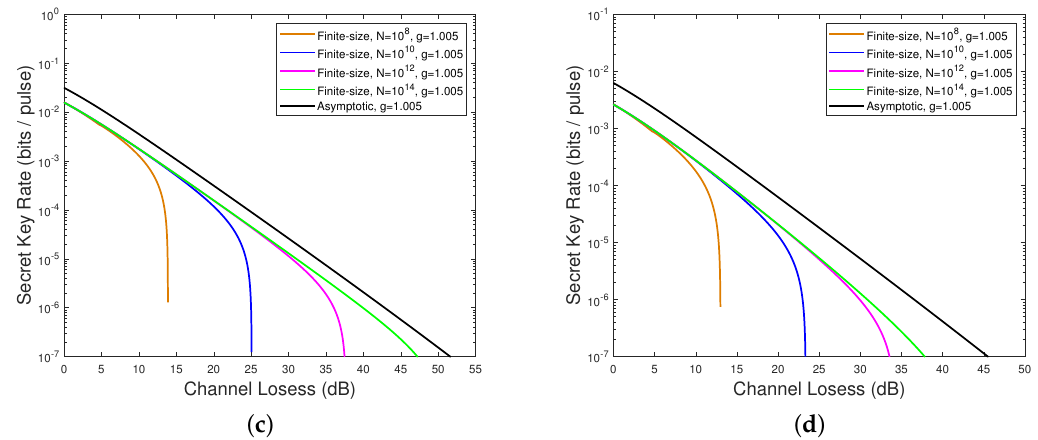
Figure 6. The secret key rate as a function of channel losses for PP DM-CVQKD protocol in the finite-size scenario. ( a ) PP four-state protocol; ( b ) PP eight-state protocol; ( c ) 1-PS PP four-state protocol; ( d ) 2-PS PP four-state protocol. The parameters are as follows: the modulation variance V M = 0.5, the channel excess noise ε = 0.01, the reconciliation efficiency β = 0.95 and the gain g =